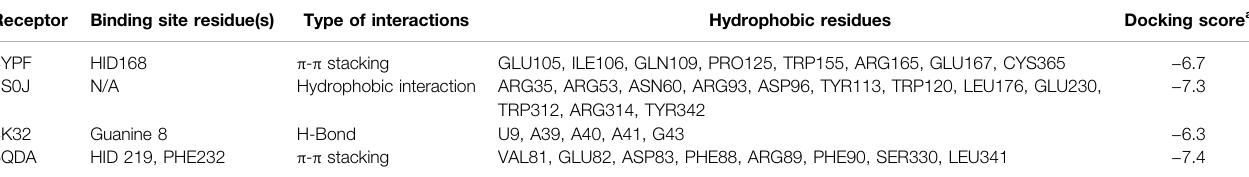
TABLE 4 | Interactions between compound 1 with the four biomolecular targets (PDB IDs: 4YPF, 1S0J, 4K32 and 6QDA). Receptor Binding site residue(s)